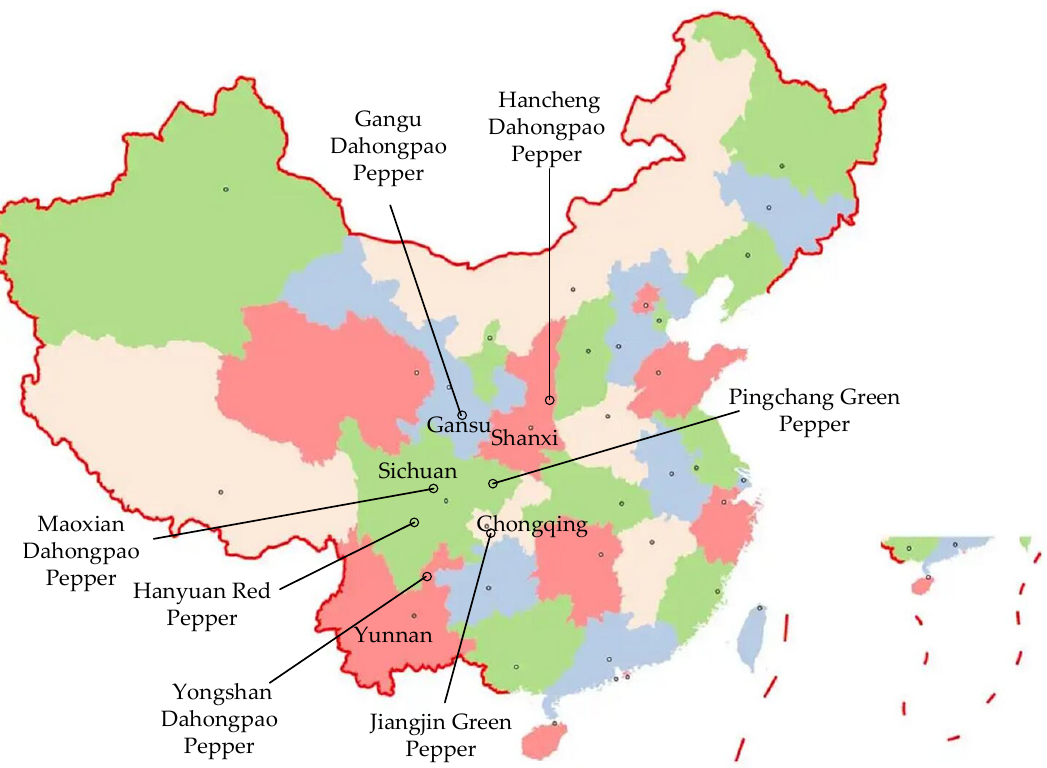
Figure 1. The geographical distribution of the seven most representative Chinese peppers.